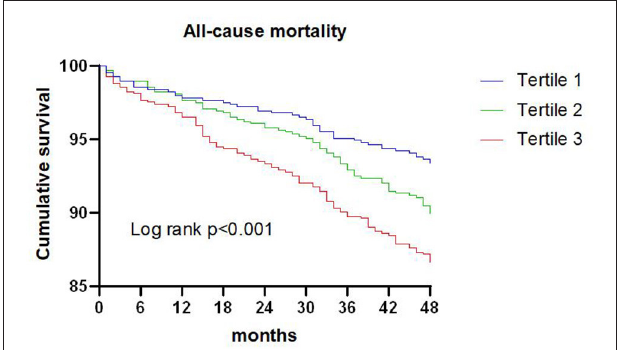
FIGURE 1 | Kaplan-Meier survival curve for all-cause mortality across triglyceride to high density lipoprotein-C ratio tertiles.